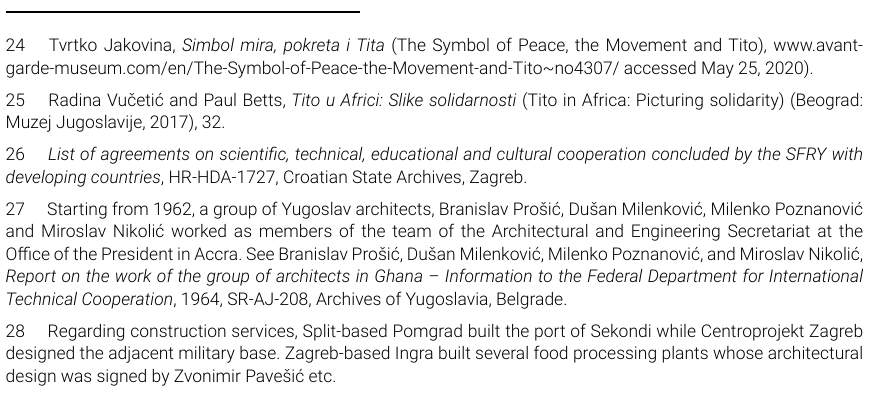
Yugoslav president Tito visiting KNUST in 1961. On the left – Engineering Laboratories building by James Cubitt (Source: Vučetić and Betts, Tito u Africi ,